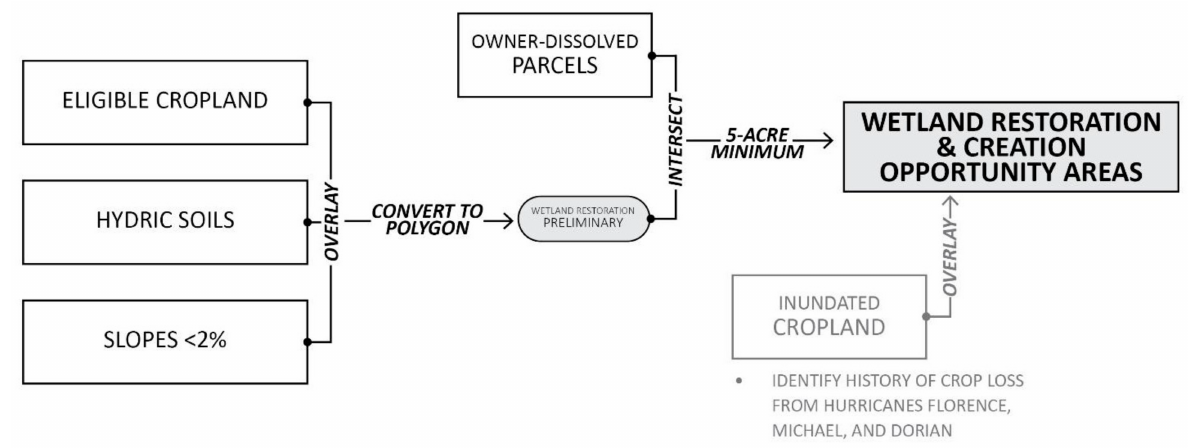
Figure 7. Diagram illustrating the general process of geospatial analysis for identifying Wetland Restoration and Creation